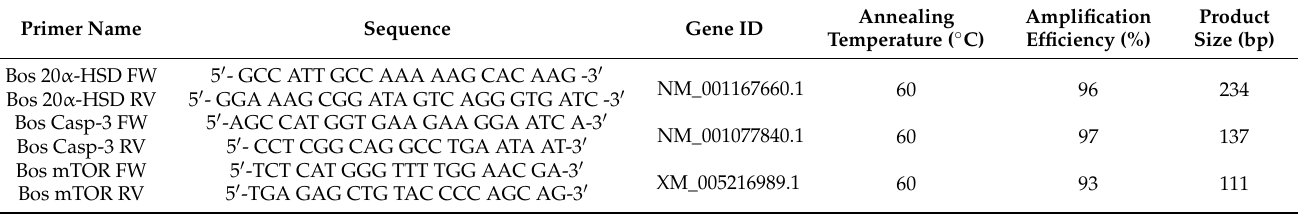
Table 1. Primers used for real-time PCR analysis of apoptosis-associated